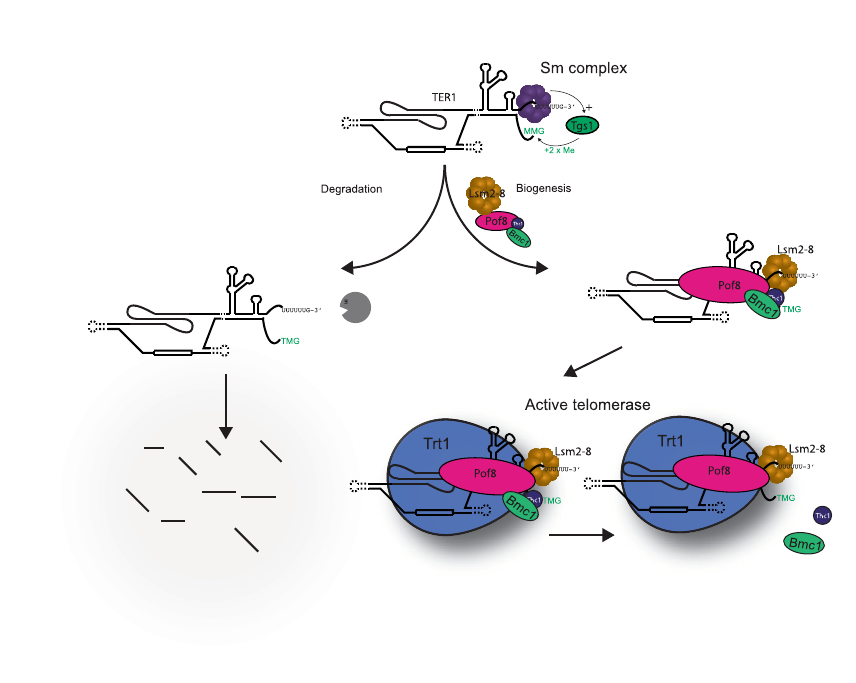
Fig. 7 Proposed model of the role of Thc1 and Bmc1 during the stepwise assembly of telomerase. After spliceosomal cleavage, the Sm complex (purple) facilitates cap hypermethylation by Tgs1 and is subsequently replaced by the Lsm2-8 complex (brown). Pof8, Thc1, and Bmc1 function during the Sm to Lsm transition. Pof8 (pink) promotes the loading of Lsm2-8 onto TER1, while Bmc1 (green) and Thc1 (blue) stabilize Pof8 binding through protein – protein and likely through protein – RNA interactions. In the absence of Pof8 on TER1, the Lsm2-8 complex cannot load, leading to TER1 degradation. Whereas Pof8 and Lsm proteins are quantitatively associated with active telomerase, Thc1 and Bmc1 are only associated with a fraction of active